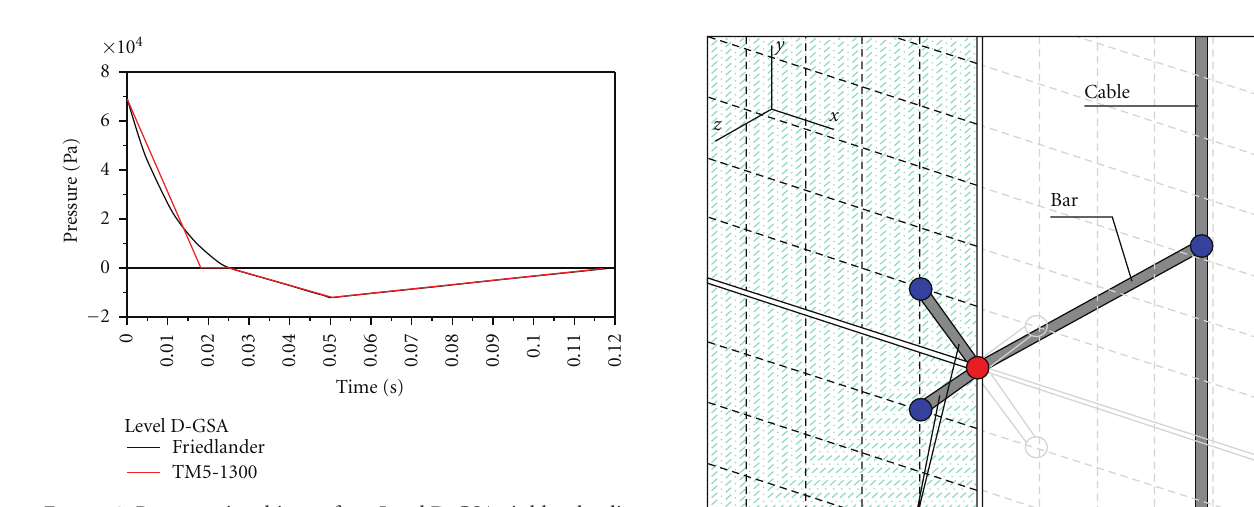
and large-strain formulation (S4R). Meshing of the model was based on 200 mm square module. The transversal ( x - direction) displacements of laminated glass panels were con- strained, so that when subjected to blast wave pressures the fac¸ade-module could only oscillate in z -direction. Similarly, R z rotations along the vertical edges of each laminated panel were constrained (Figure 3). Each φ = 36 mm diameter cable consisted in 2-node linear displacement truss elements (T3D2), having a cross- section area equal to half the nominal one. In this prelim- inary phase, the cables were pinned at the upper end and the initial pretension force ( H 0 = 300 kN) was imposed at their base in the form of a vertical displacement. Along